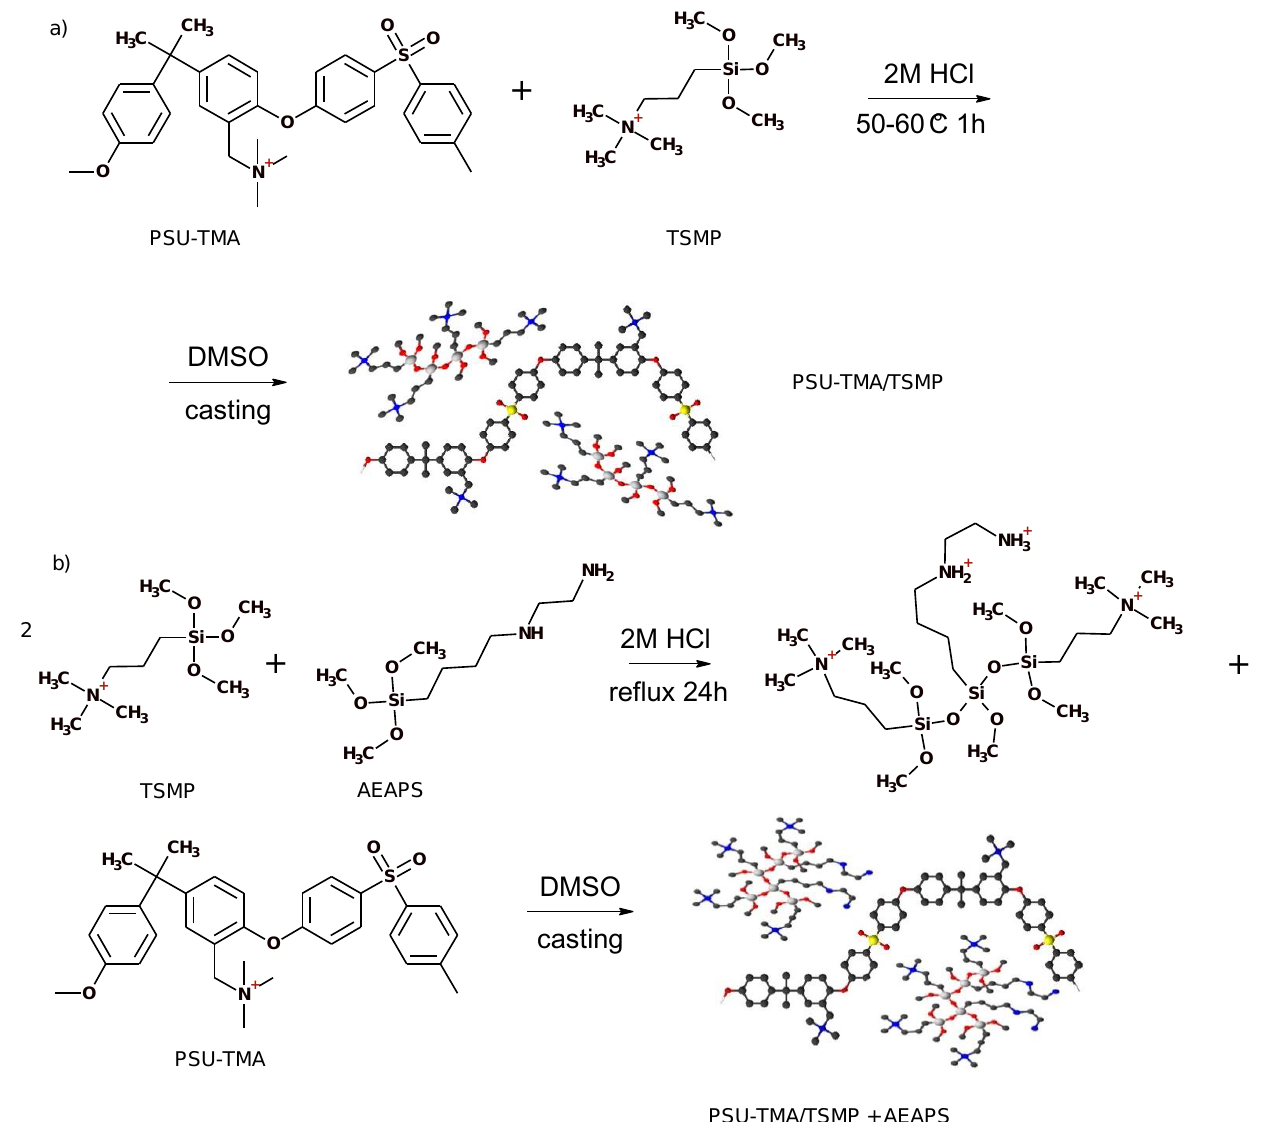
Figure 1. Synthesis routes for hybrid membranes by ( a ) in-situ and ( b ) ex-situ sol–gel technique.